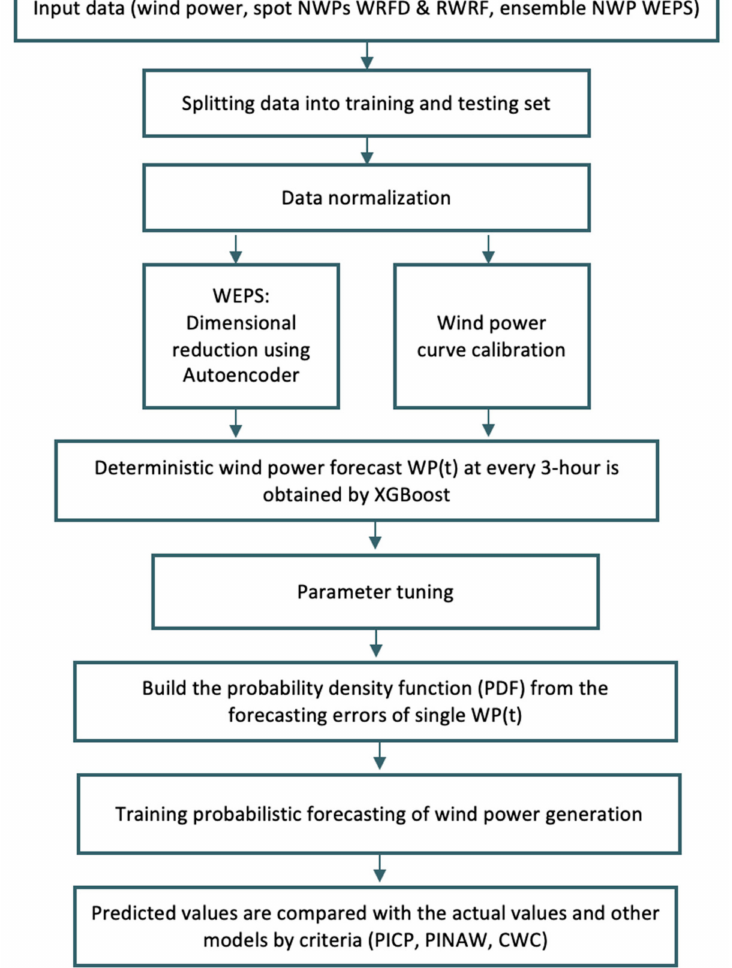
Figure 8. Flow chart of probabilistic forecasting. Step 1: The input data include historical wind power measurements, spot NWPs (WRFD, RWRF), and NWP ensemble wind speeds